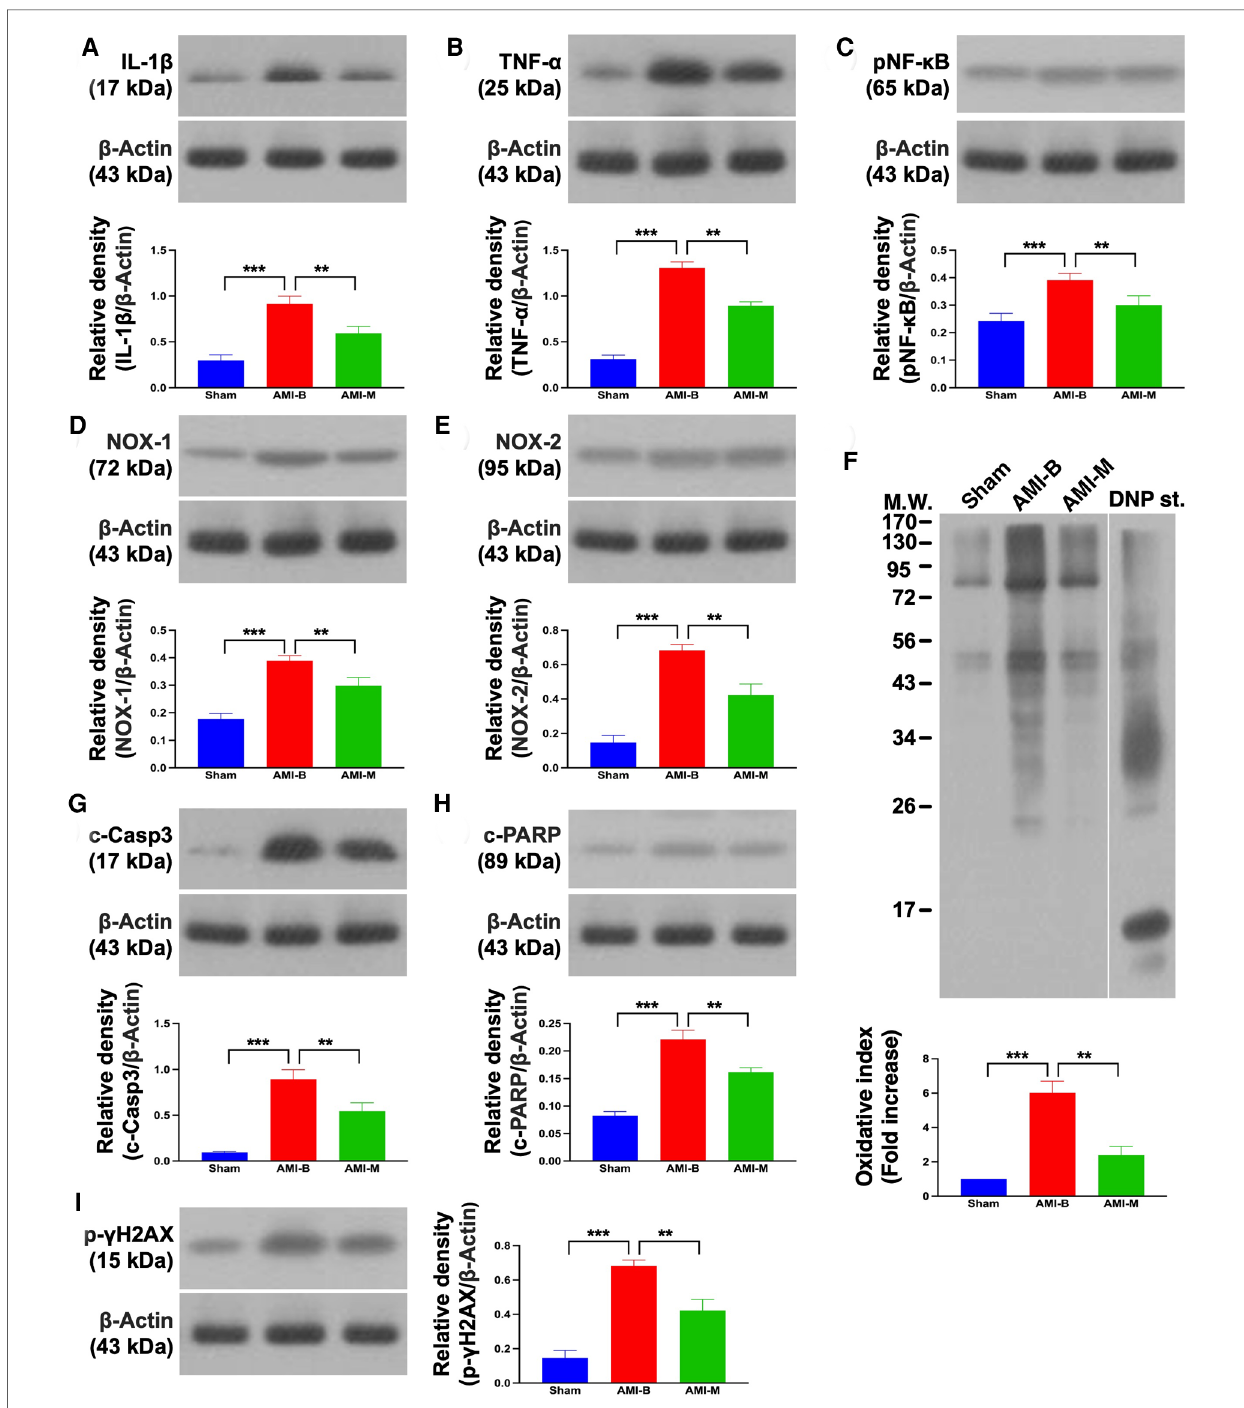
FIGURE 7 Protein expressions of in fl ammation, oxidative stress, and apoptosis/DNA damage in LV infarct myocardium 5 months after AMI induction. ( A ) Protein expression of IL-1 β ; *** p <0.0001; ** p <0.001. ( B ) Protein expression of TNF- α ; *** p <0.0001; ** p <0.001. ( C ) Protein expression of NF- κ B; *** p < 0.0001; ** p <0.001. ( D ) Protein expression of NOX-1; *** p <0.0001; ** p <0.001. ( E ) Protein expression of NOX-2; *** p <0.0001; ** p <0.001. ( F ) Oxidized protein expression; *** p <0.0001; ** p <0.001 (Note: the left and right lanes shown on the upper panel represent protein molecular weight marker and control oxidized molecular protein standard, respectively). ( G ) Protein expression of cleaved caspase 3 (c-Casp3); *** p <0.0001; ** p < 0.001. ( H ) Protein expression of c-PARP; *** p <0.0001; ** p <0.001. ( I ) Protein expression of γ -H2AX; *** p <0.0001; ** p <0.001. Sham (group 1), sham-operated control; AMI-B (group 2), AMI+buffer; AMI-M (group 3), AMI+hBMMSC; AMI, acute myocardial infarction; hBMMSCs, human bone marrow-derived mesenchymal stem cells; LV, left ventricular; IL, interleukin; TNF, tumor necrosis factor; NF, nuclear factor; MW, molecular weight; DNP, 1-3 dinitrophenylh